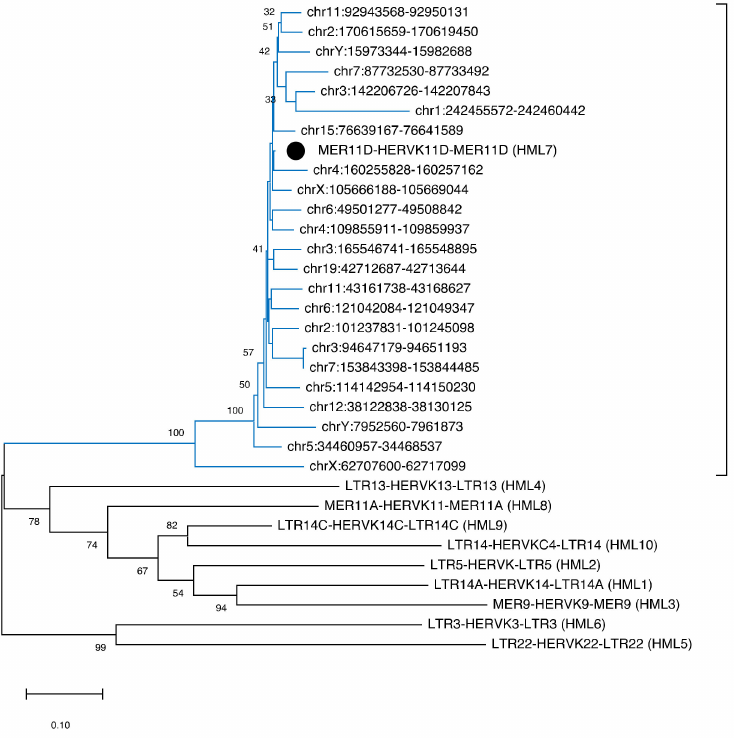
Figure 3. Phylogenetic tree of HML7 proviral loci. The identified HML7 proviruses were analyzed with the maximum likelihood method, including also the Dfam reference proviral sequences of all HERV-K groups (HML1 to HML10). Phylogenies have been statistically tested through the bootstrap method with 100 replicates. The monophyletic group formed by the HML7 proviruses and including the HML7 group Dfam reference (black dot) is highlighted with blue